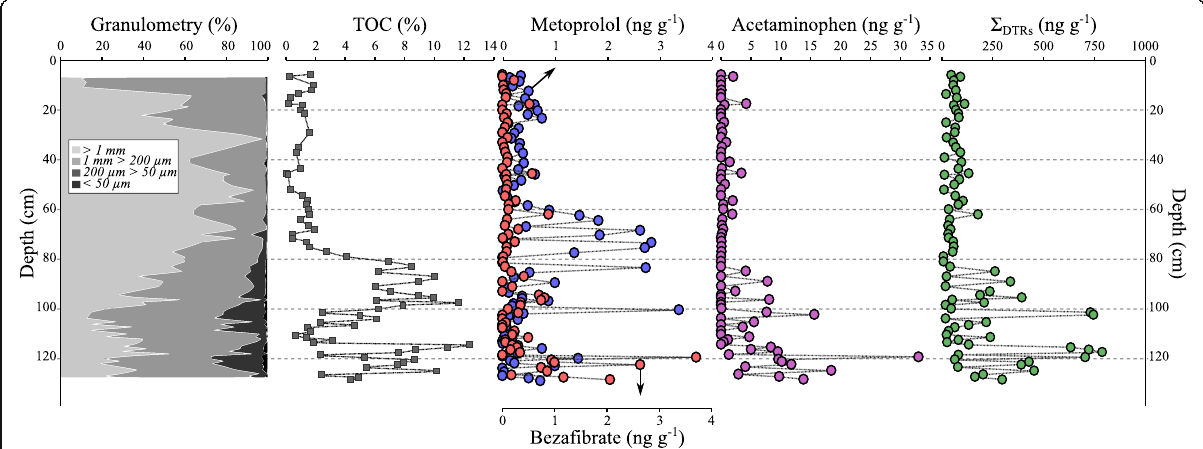
Fig. 4 Vertical distribution of the grain size, the total organic carbon, the concentrations of Metoprolol, Bezafibrate, Acetaminophen and the sum of all DTRs ( ∑